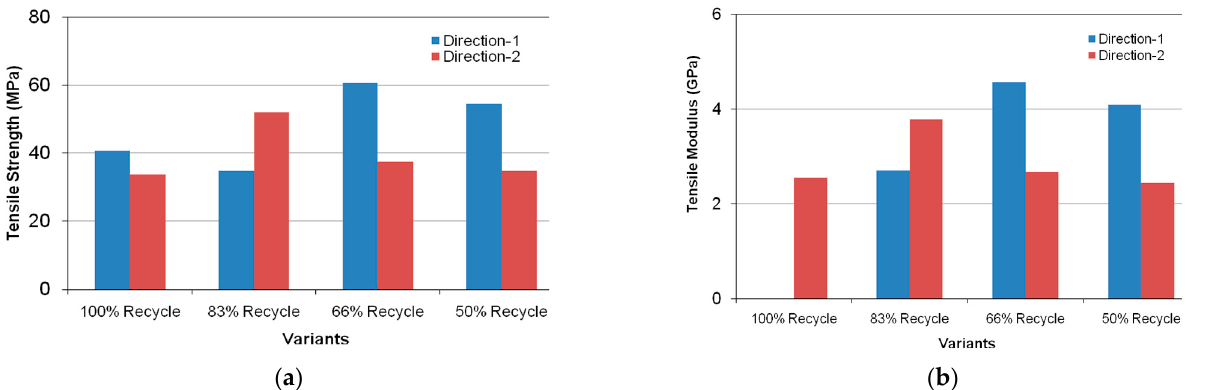
Figure 8. ( a ) Tensile strength (MPa) response from different recycle constituents for Longitudinal and Transverse , respectively; ( b ) Corresponding Tensile Modulus (GPa) for the same variants. The dashed lines represent virgin 30 wt% PP-GF LFT for the corresponding directions and 100% recyclate is the as-received PP-GF scrap.